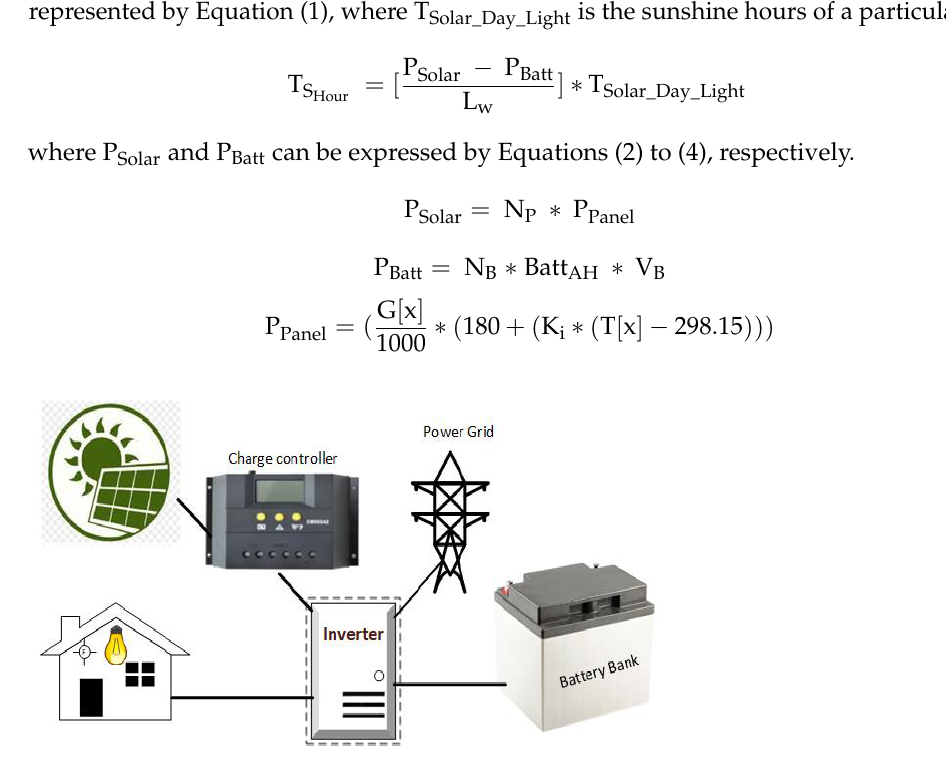
Figure 2. Structure of considered grid-tied nanogrid system.